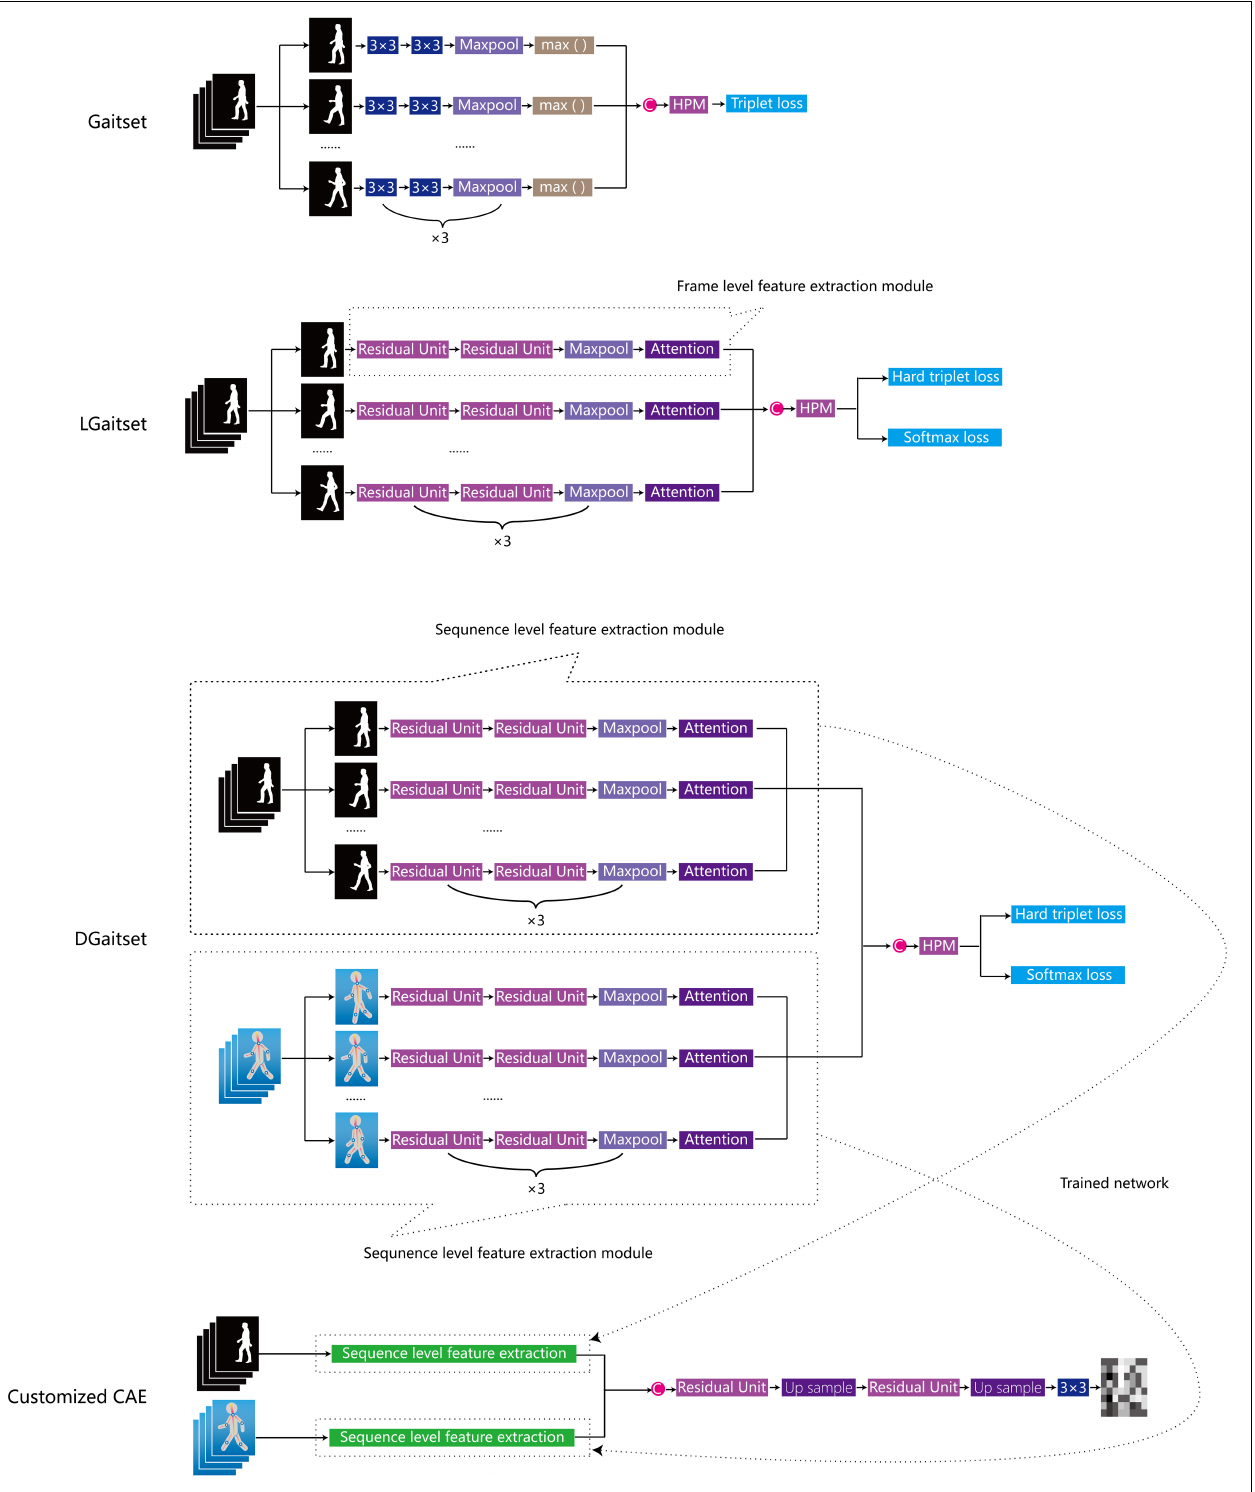
FIGURE 4 | Overview of network structure of feature extraction methods. C, concat; HPM, horizontal pyramid mapping, attention: attention module, 3 × 3: 3 × 3 convolution kernel; CAE, convolutional auto-encoder.